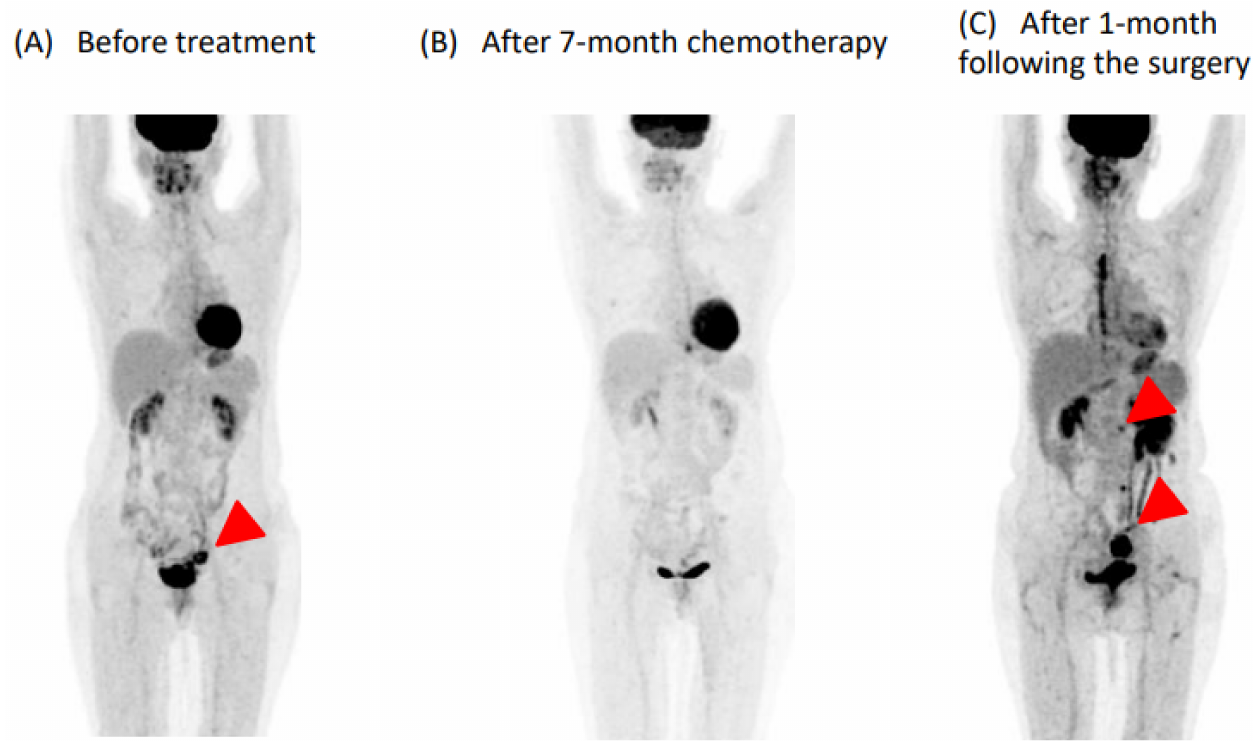
Figure 1. FDG-PET/CT course of cervical cancer ( A ) FDG-PET showed abnormal accumulation in the paracervical ligament (arrow). ( B ) Disappearance of a significant ligament uptake on FDG-PET/CT during BEV therapy. ( C ) FDG-PET showed abnormal accumulation in the membrane of sigmoid colon and para-aortic lymph nodes at 3 months after mitral valve repair